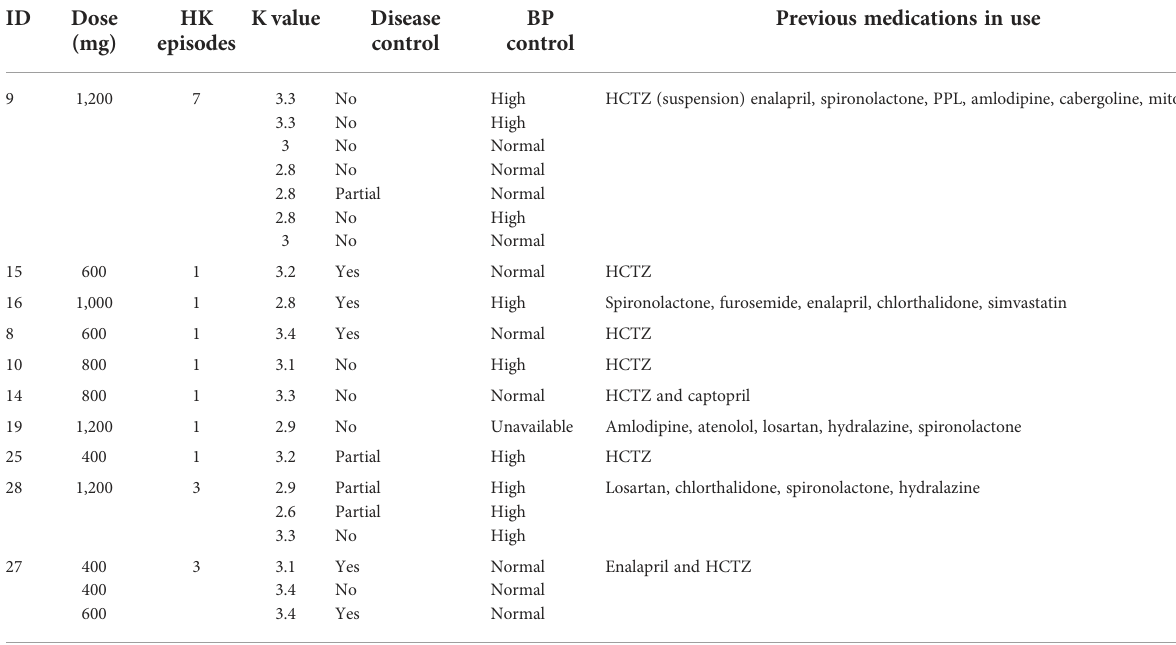
Previous medications in